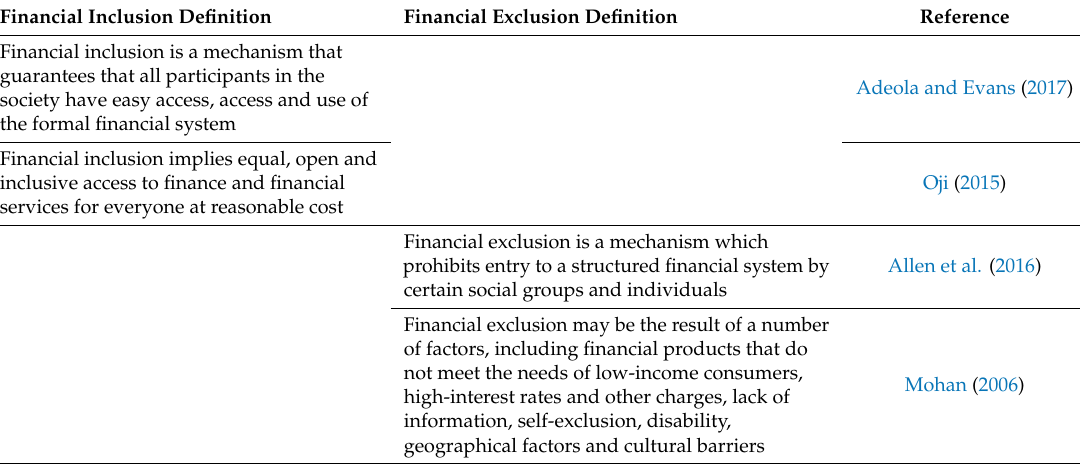
Table 1. Main definitions of financial inclusion and